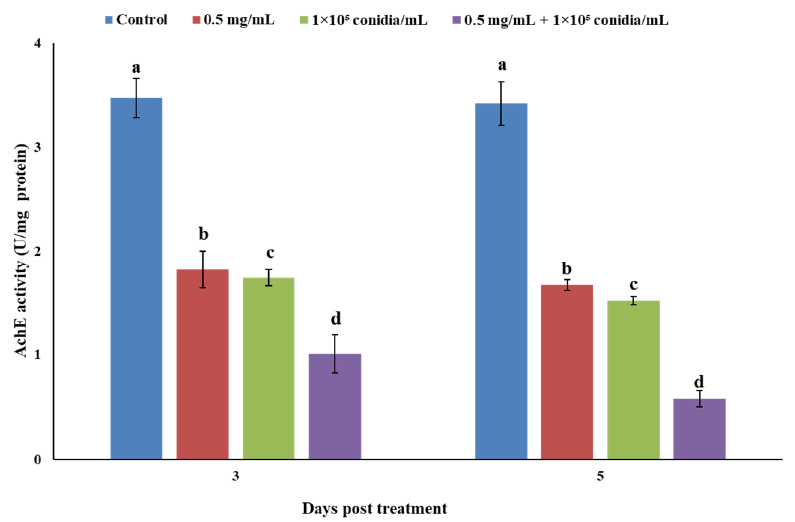
Figure 4. Acetylcholinesterase (AChE) activity of M. usitatus in response to individual or joint treatments of A. attenuatus and matrine. Bars having different letters show significant differences between treatments at different time intervals.